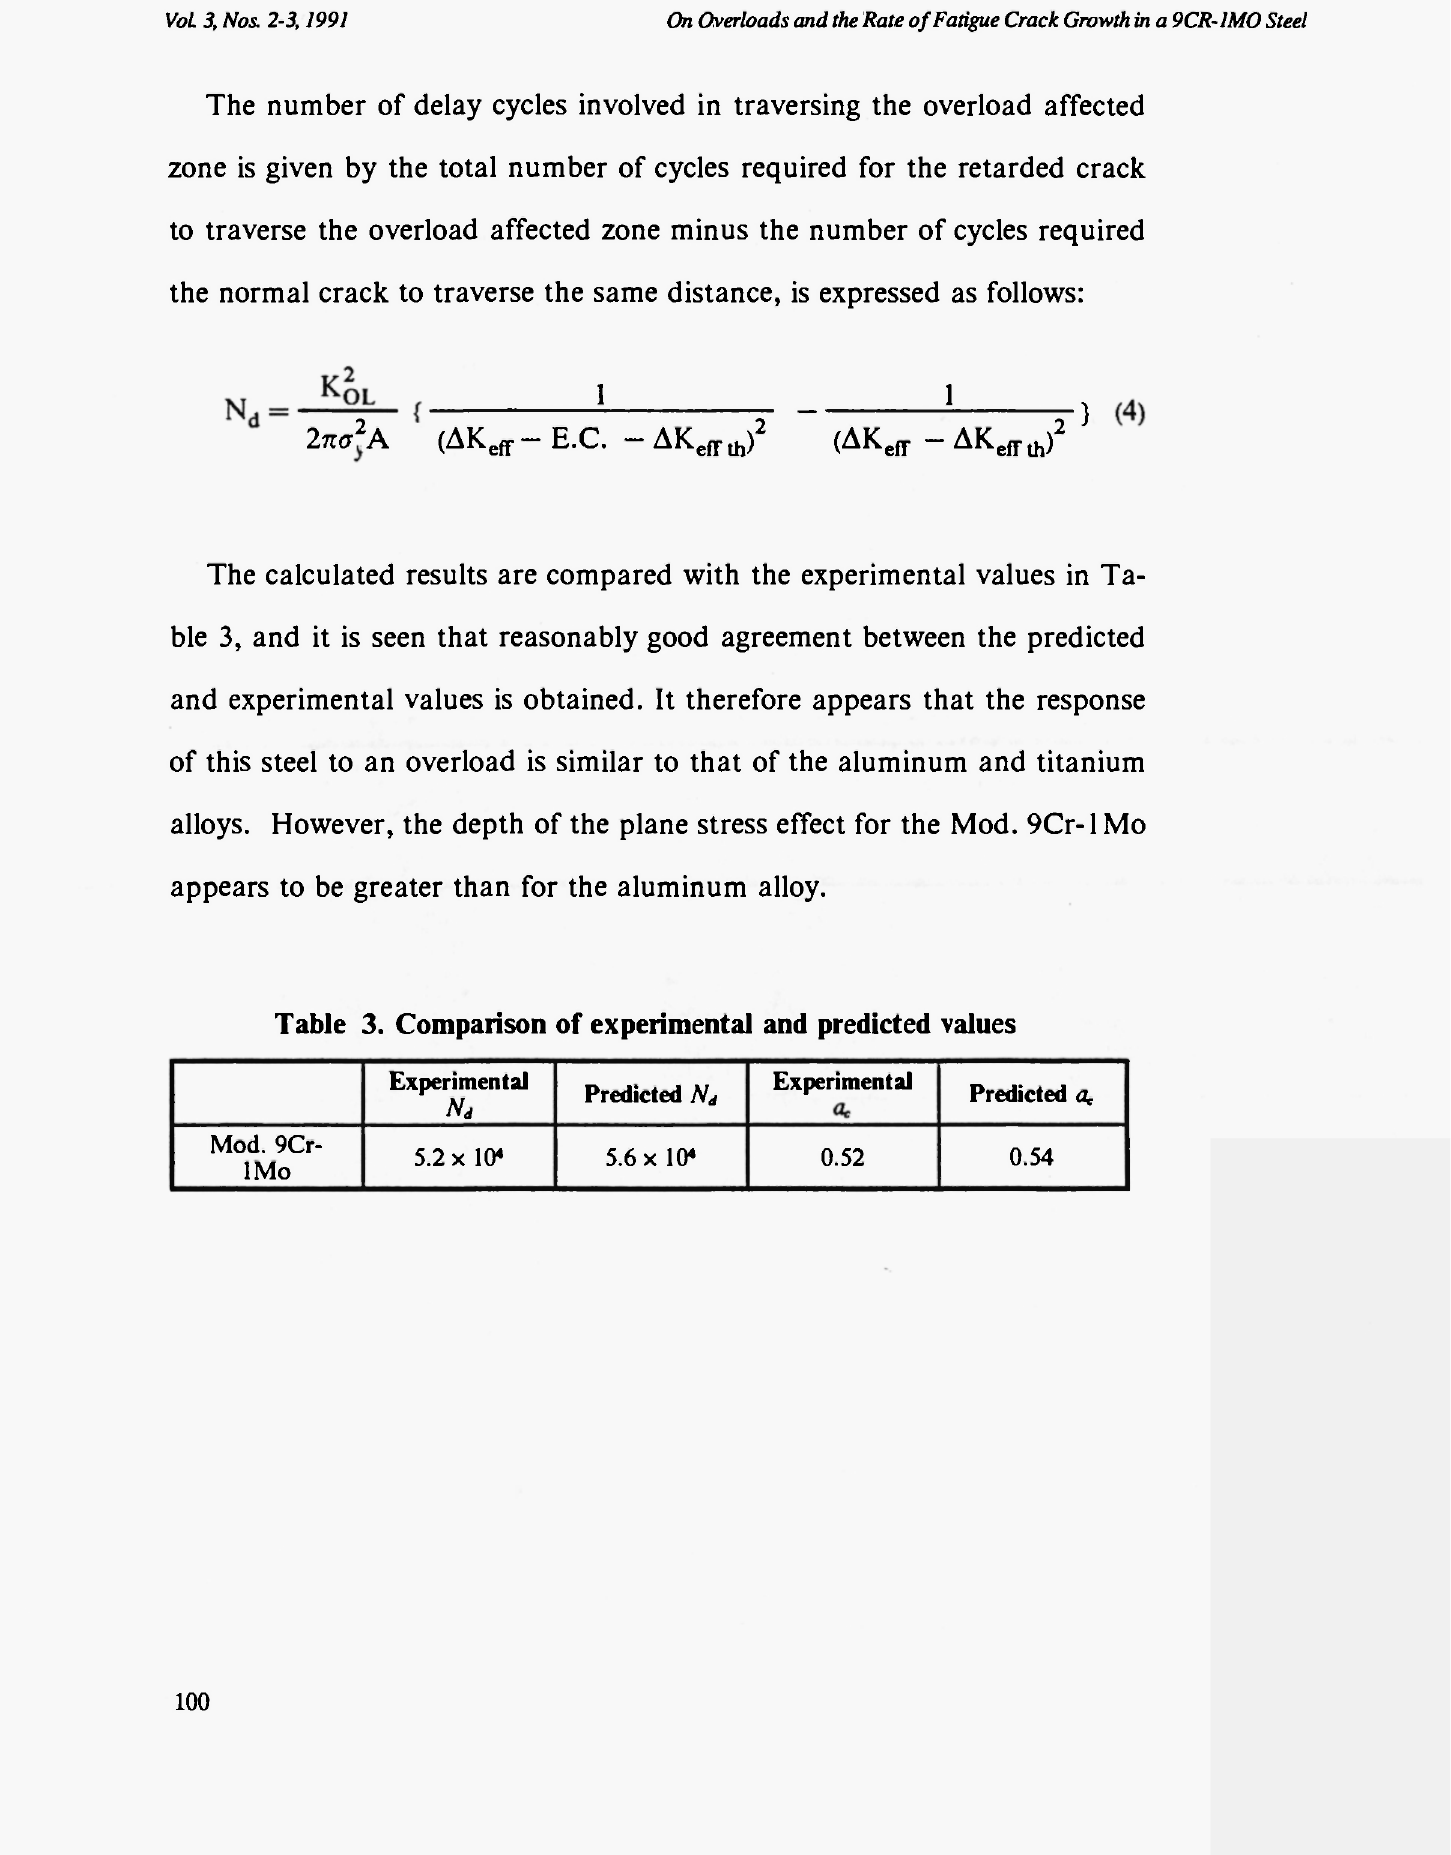
Table 3. Comparison of experimental and predicted